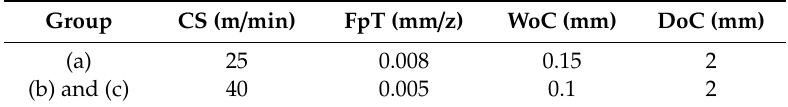
Figure 10. Cutting force comparison of predicted and experimental results. ( a ) Under single tooth; ( b ) Under di ff erent processing parameters. Table 1. Milling parameters.